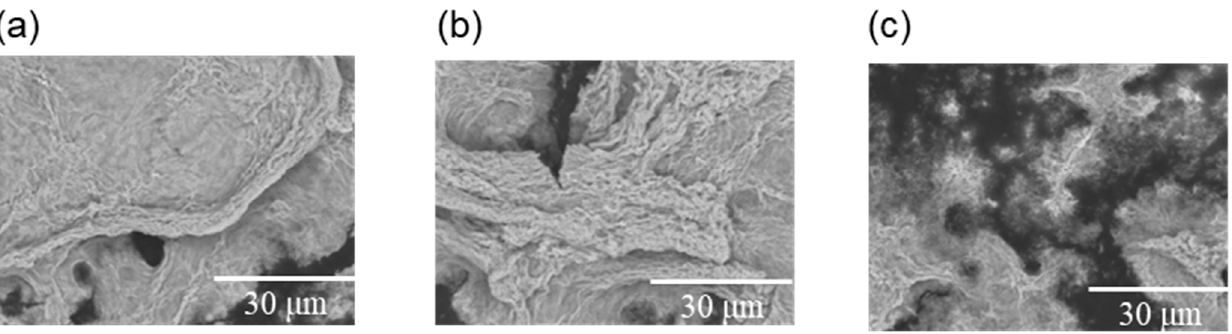
Figure 5. Scanning electron microscopy (SEM). ( a ) A β 11-29, ( b ) A β 11-29 co-incubate GSGYR, ( c ) A β 11-29 co-incubate RYGSG. ( c ) A β 11-29 co-incubate RYGSG.